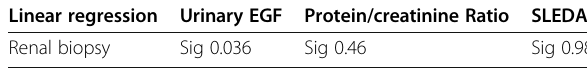
Table 4 Linear regression for renal biopsy with each of urinary EGF, protein/creatinine ratio and SLEDAI Linear regression Urinary EGF Protein/creatinine Ratio SLEDAI Renal biopsy